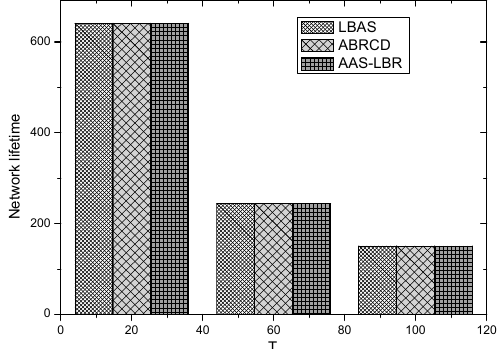
Figure 35. Network lifetime of three schemes under different cycles with r = 28 m.